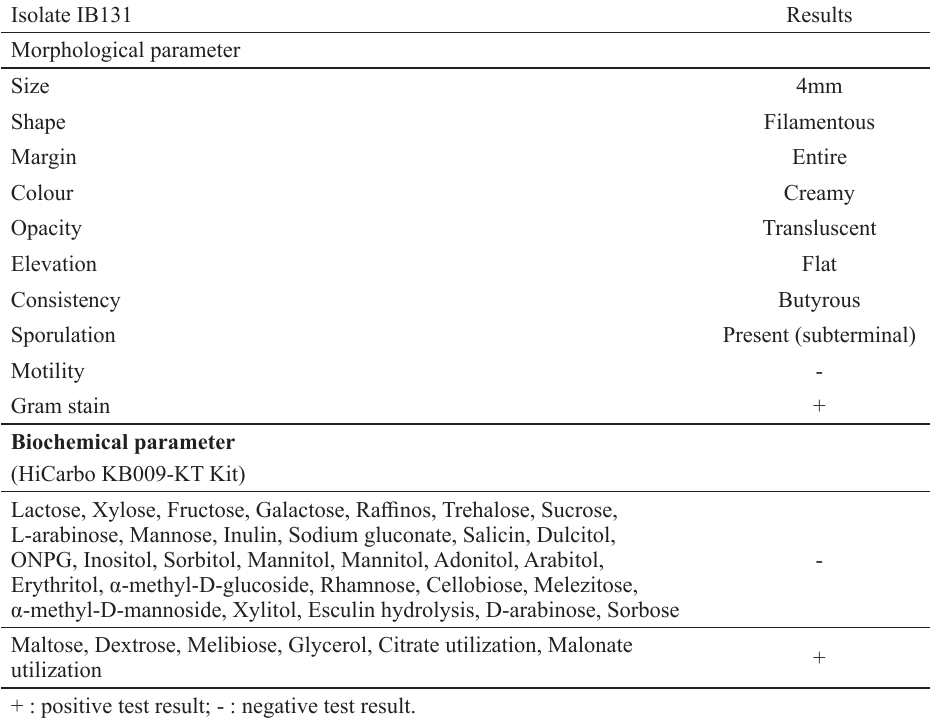
Morphological and biochemical characterization of the isolate